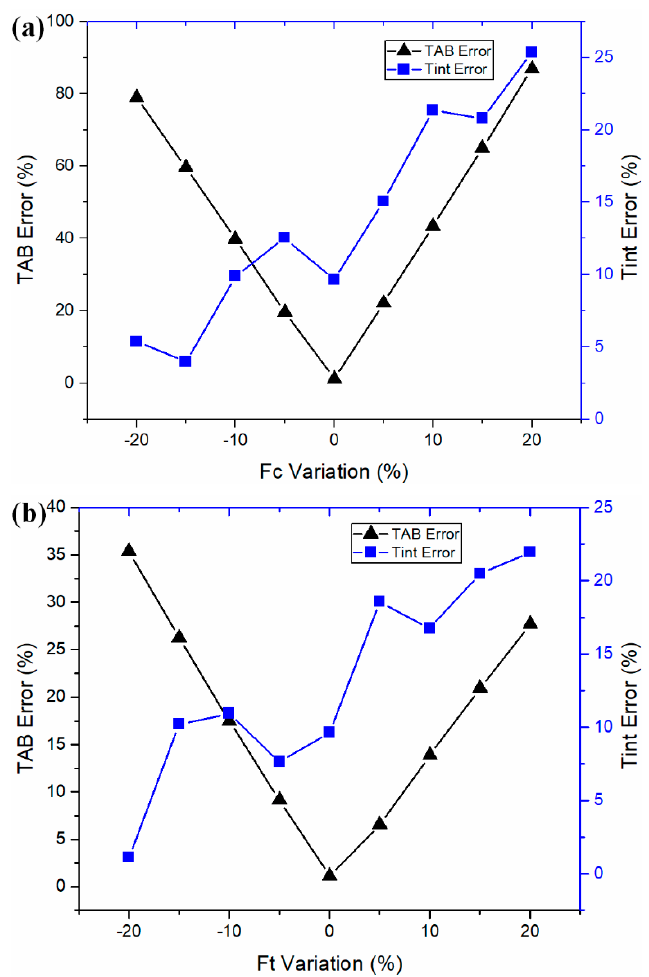
Figure 4. Sensitivity analyses of ( a ) cutting force and ( b ) thrust force on the temperature prediction.